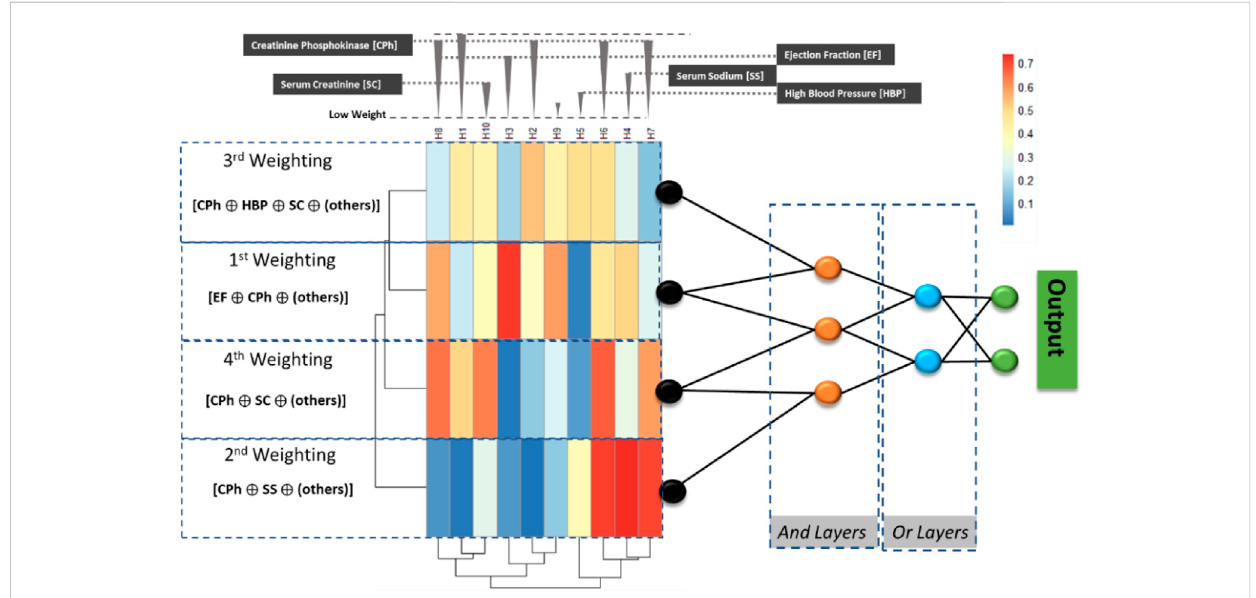
FIGURE 2 The implemented ProbLONNs contain distributed weights in the initial layer representing the weight distribution. The number of neurons in the hidden layers is de fi ned according to the parameters presented in Table 2. In a multiclass problem, the implemented model tries to predict between, for